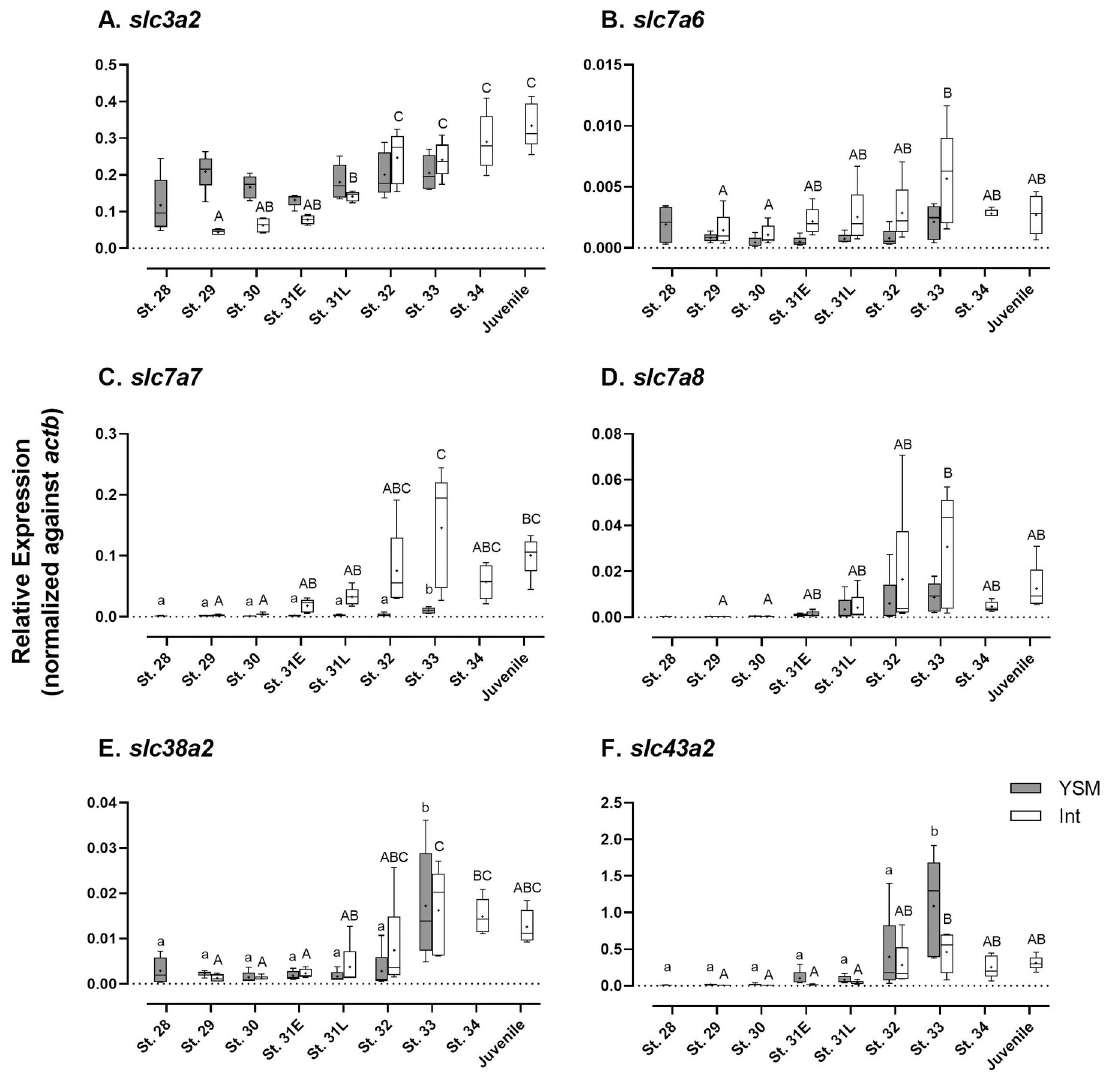
Fig 3. Developmental changes in gene expression of amino acid transporters of putative basolateral locality. (A) slc3a2 ; (B) slc7a6 ; (C) slc7a7 ; (D) slc7a8 ; (E) slc38a2 ; (F) slc43a2 . Data are presented using box and whisker diagrams of N = 5. Uppercase and lowercase letters indicate significant developmental differences in embryonic intestine and yolk sac membrane, respectively after one way ANOVA, Tukey’s test ( P <